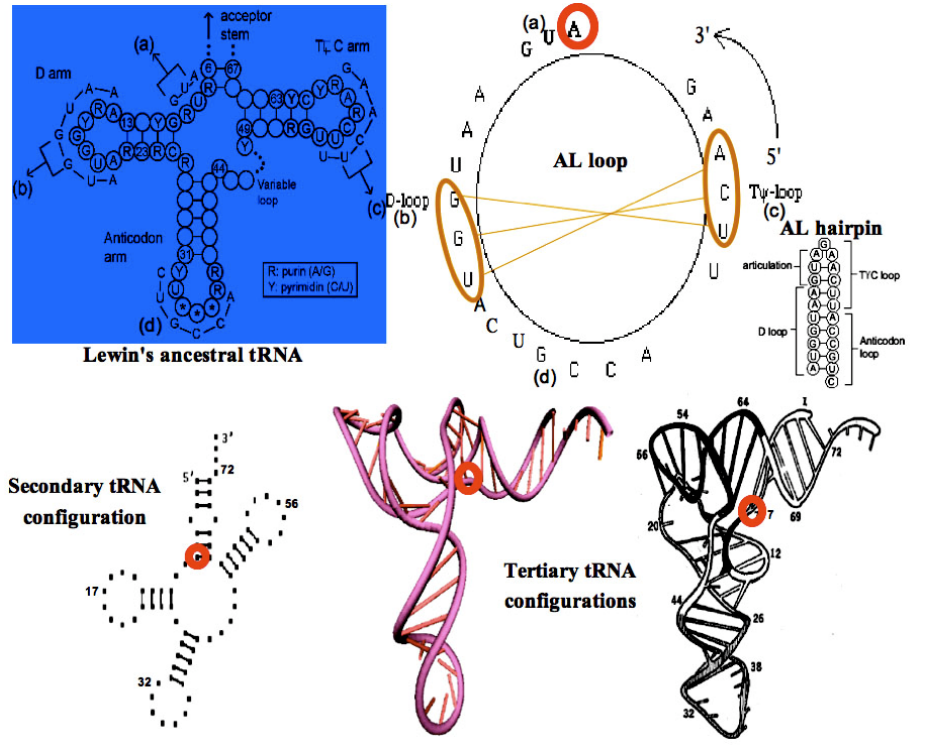
Figure 2. Secondary structure of the Lewin's template tRNA with 4 parts (a,b,c,d) corresponding to the Gly-tRNA of Arabidopsis thaliana (top left); AL loop and hairpin (top right) with the pivot A and two complementary triplets (top right) causing the tRNA tertiary structure from secondary one